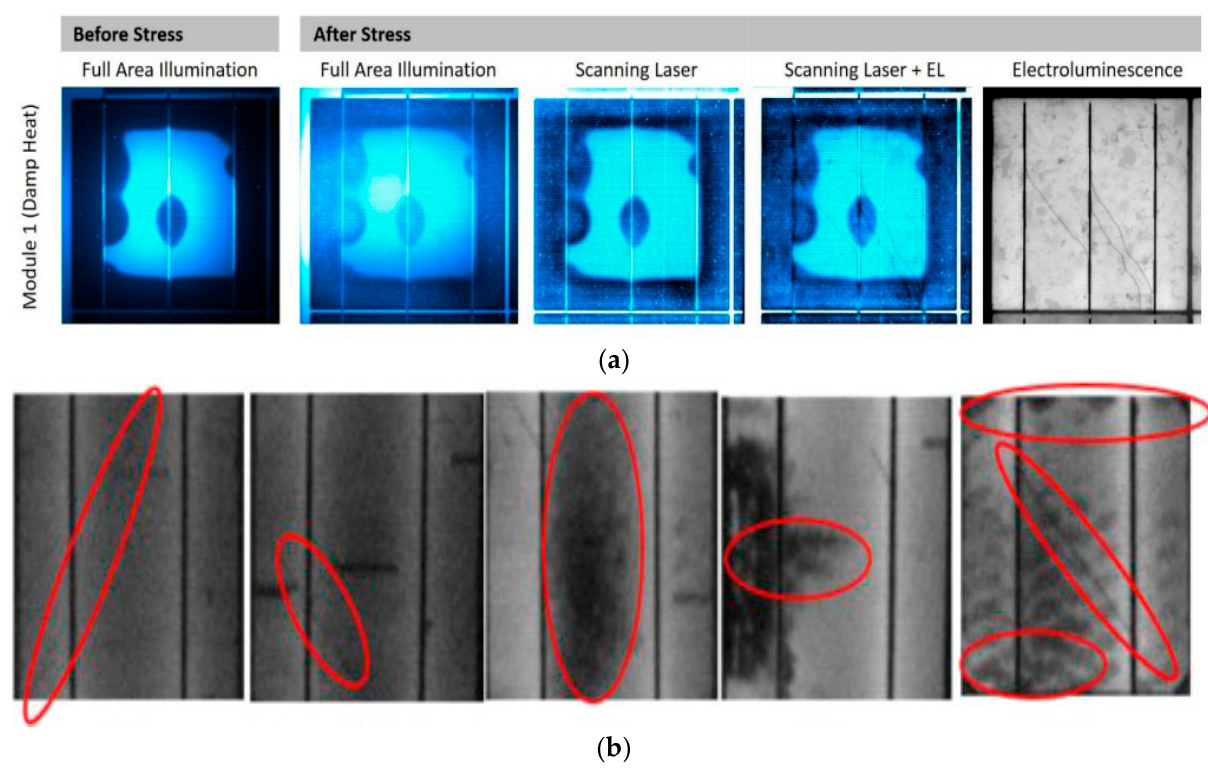
Figure 5. Solar cell cracks: ( a ) UVF images after outdoor exposure, but before stress testing, and (right) images after either damp heat or thermal cycling [37]; ( b ) different microcrack orientations indicated by red circles as described by